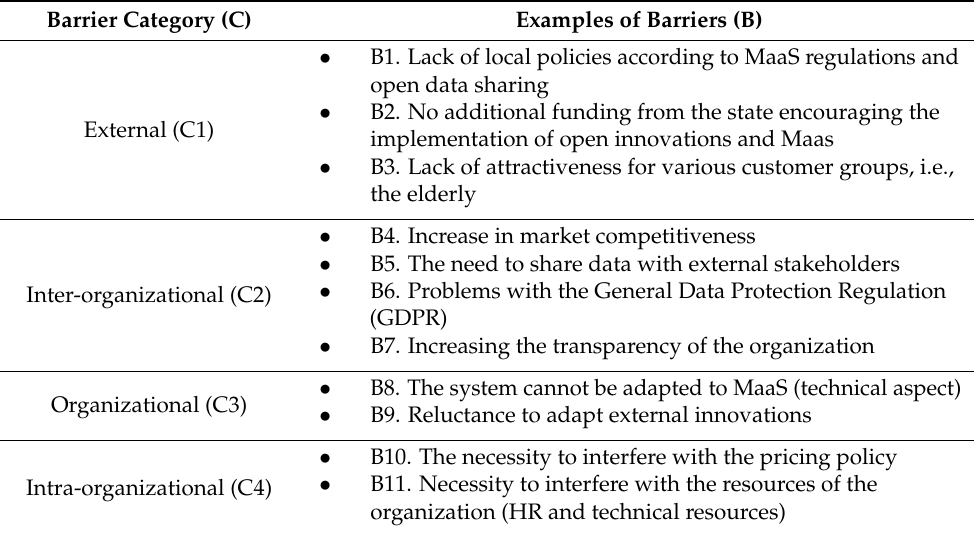
Table 1. Structured barriers to the development of open innovations in shared mobility.